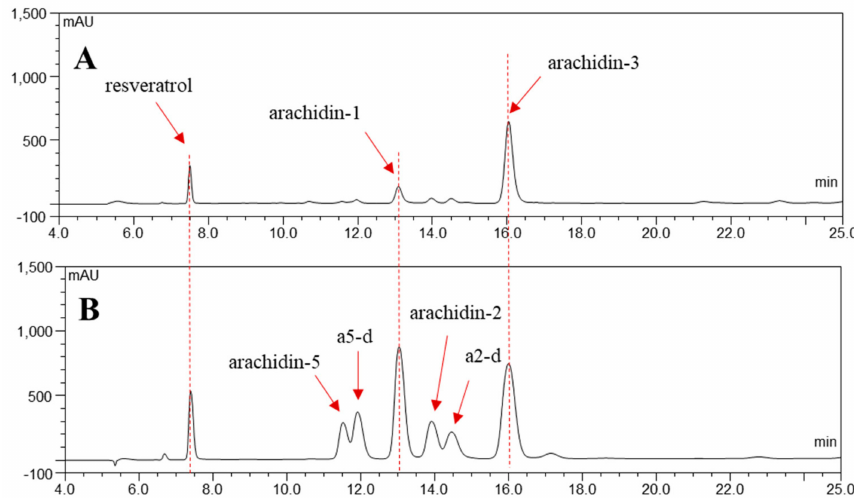
Figure 2. Comparison of secreted stilbenoid profiles before and after elicitation medium optimization. HPLC chromatograms (UV 340 nm) of ethyl acetate extracts from the medium of peanut cv. Hull hairy roots of line 3 after 72 h of treatment with di ff erent elicitors: ( A ) 100 µ M MeJA 9 g / L CD in a 50 mL elicitation medium and ( B ) 125 µ M MeJA, 18 g / L CD, 3 mM H 2 O 2 and 1 mM MgCl 2 in a 100 mL elicitation medium. a5-d, arachidin-5 derivative; a2-d, arachidin-2